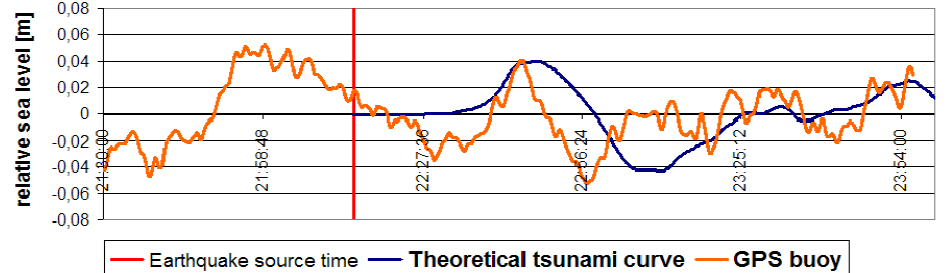
Fig. 7. Sea level curve acquired during the M 7 . 6 earthquake on 6 April 2010 off Banda Aceh (Indonesia). The corrected and de-trended GPS Figure 7: Sea Level curve acquired during the M7.6 earthquake on April 6th, 2010 off Banda 4 derived sea level curve (orange) and a theoretical tsunami curve (blue) based on a forward modelling (A. Babeyko, GFZ Potsdam, personal communication, 2010) are Aceh (Indonesia). Shown is the corrected and de-trended GPS derived sea level curve 5 (orange) and a theoretical tsunami curve (blue) based on a forward modeling (A. Babeyko, 6 GFZ Potsdam, personal communication). 7